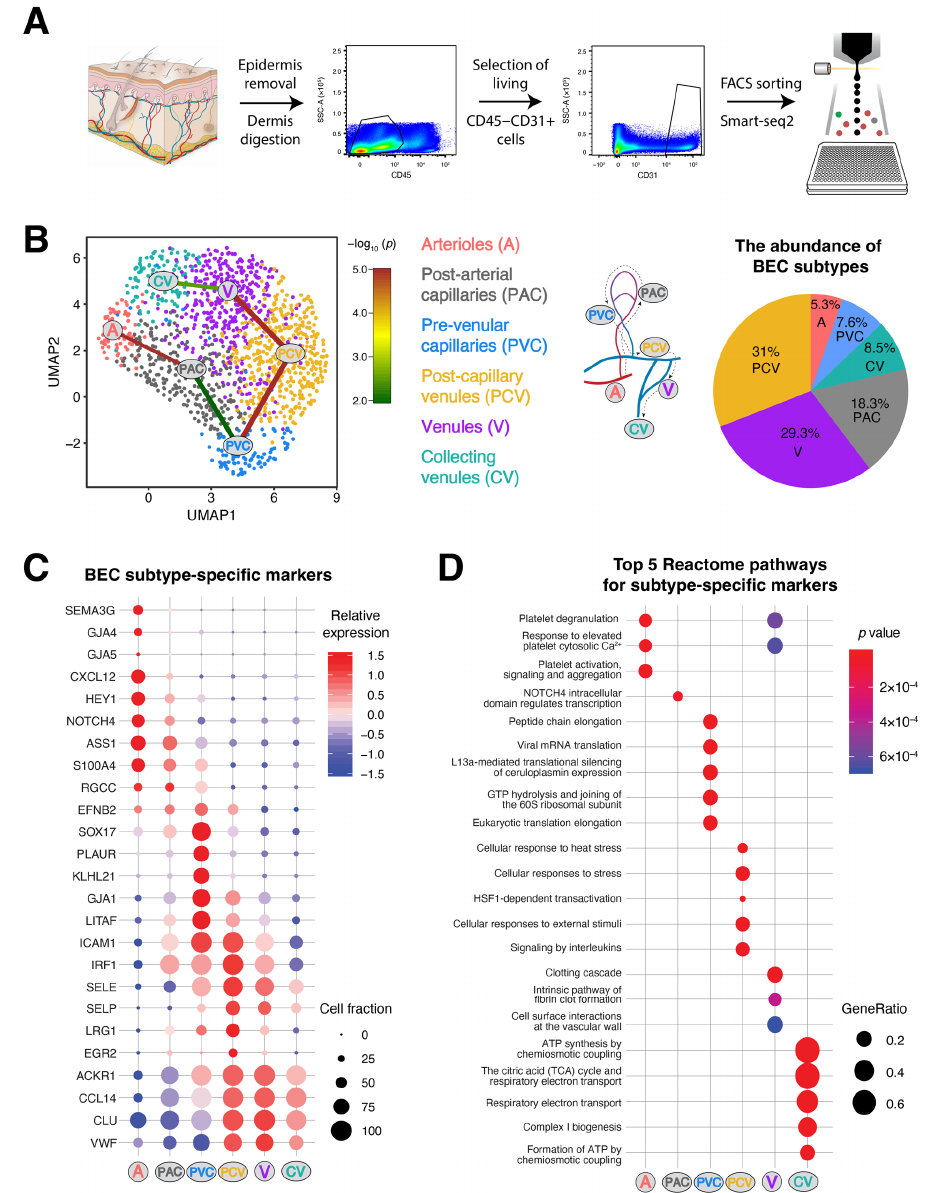
Figure 1 . Distinct transcriptomic patterns signify six human dermal blood vascular endothelial cell subtypes. ( A ) Isolation workflow of endothelial cells (ECs) from healthy human skin tissues for scRNA-seq. ( B ) Identification of six different subtypes of BECs, with each cluster corresponding to a particular vessel segment as denoted in the middle panel: arterioles (A), post-arterial capillaries (PAC), pre-venular capillaries (PVC), post-capillary venules (PCV), venules (V) and collecting venules (CV). The connections among different clusters indicate the inferred pseudotime trajectories ( p < 0.05) using the StemID2 algorithm, where the color of the connections denotes the − log 10 ( p value) and the thickness reflects how densely a connection is populated with cells. The abundance of each BEC subtype within the total population is shown in the right panel. ( C ) Expression patterns of selected markers in different BEC clusters, where color intensity indicates the relative abundance level and the dot size denotes the proportion of cells with detectable expression in the respective cluster. ( D ) Top 5 Reactome pathways enriched in each BEC subpopulation. ‘GeneRatio’ indicates the ratio of genes from our input list that are related to a specific pathway over the total number of genes used as